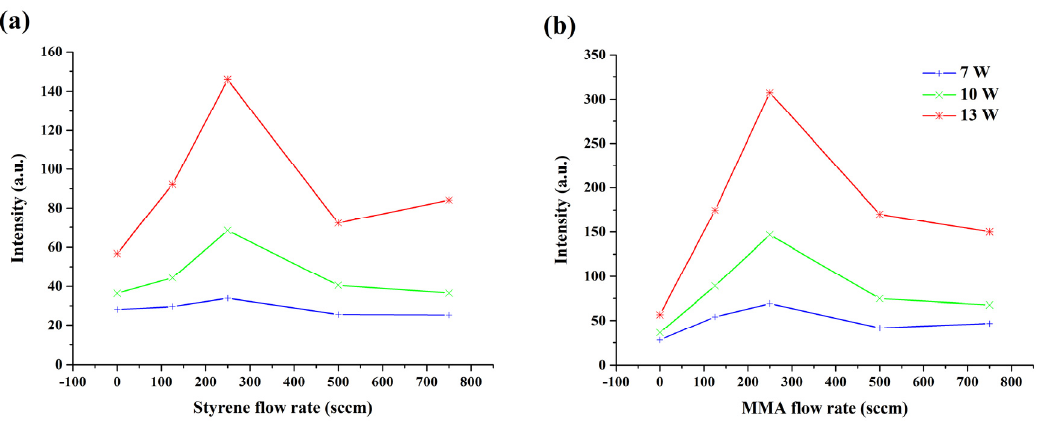
Figure 3. Dependence of the C line emission intensity on the carrier gas flow rate at different powers for the ( a ) styrene and ( b ) methyl methacrylate (MMA) monomers.